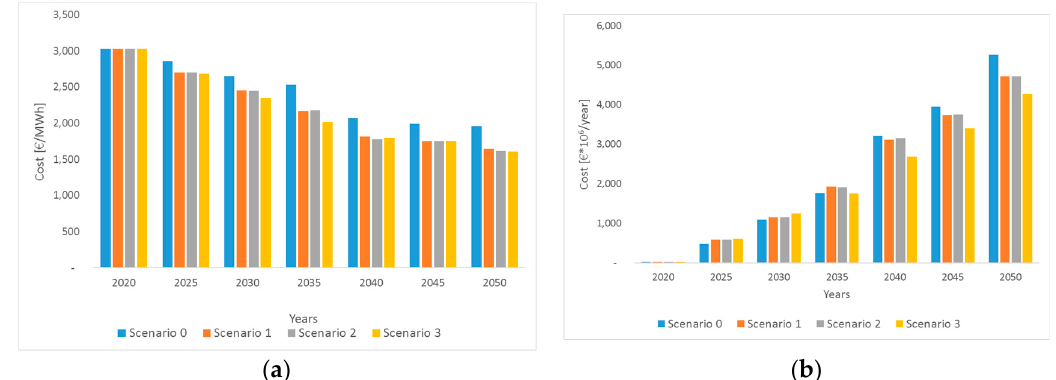
Figure 6. Evolution of the operational cost ( a ) and the annualized investment cost ( b ) for Scenarios 1, 2 and 3.